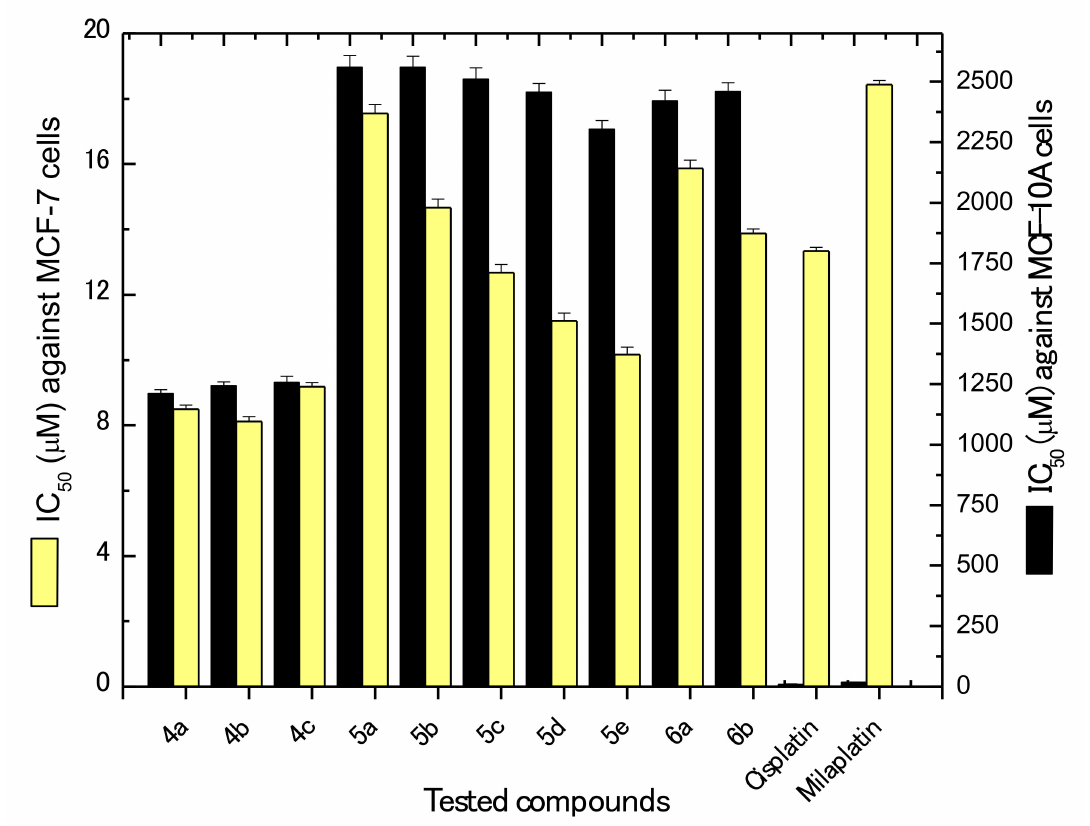
Figure 2. In vitro cytotoxic activities of the tested compounds 4 – 6 against MCF-7 and MCF-10A cell